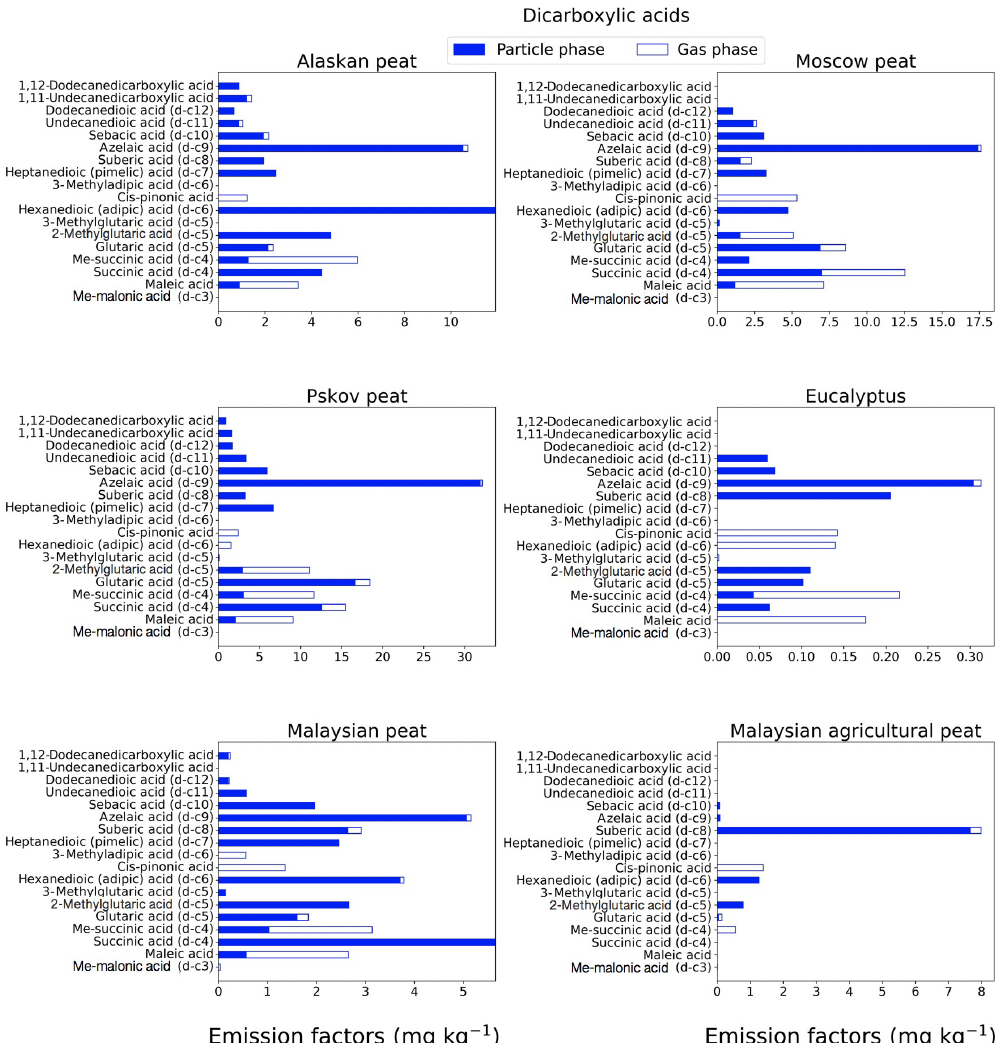
Figure 3. EFs for dicarboxylic acids in both the particle phase (solid bars, filter samples) and gas phase (open bars, XAD samples) from fresh biomass-burning emissions for six different fuel types. We did not burn fuels in replicates, and the standard-deviation (SD) values were calculated based on replicate analysis of emissions from similar fuels (with identical experimental conditions) during our previous combustion campaigns (Yatavelli et al., 2017), where SD ranged between 10% and 17% for dicarboxylic